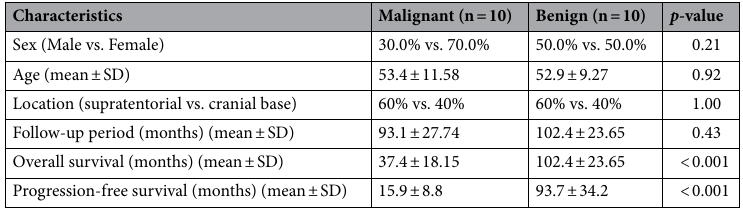
Table 1. Clinical characteristics of